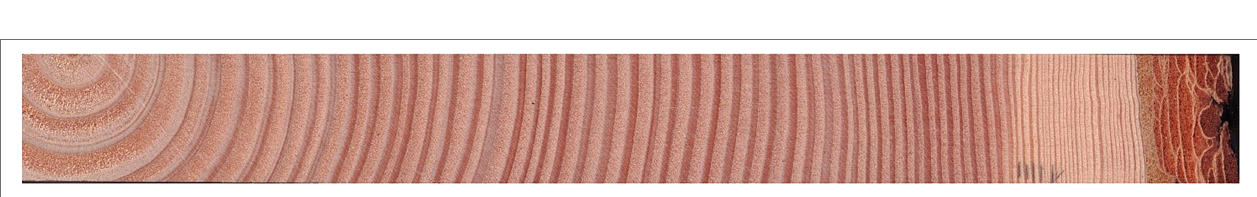
FIGURE 1 | Annual ring of Douglas-fir mature heartwood (left) and resin canal in sapwood (right).